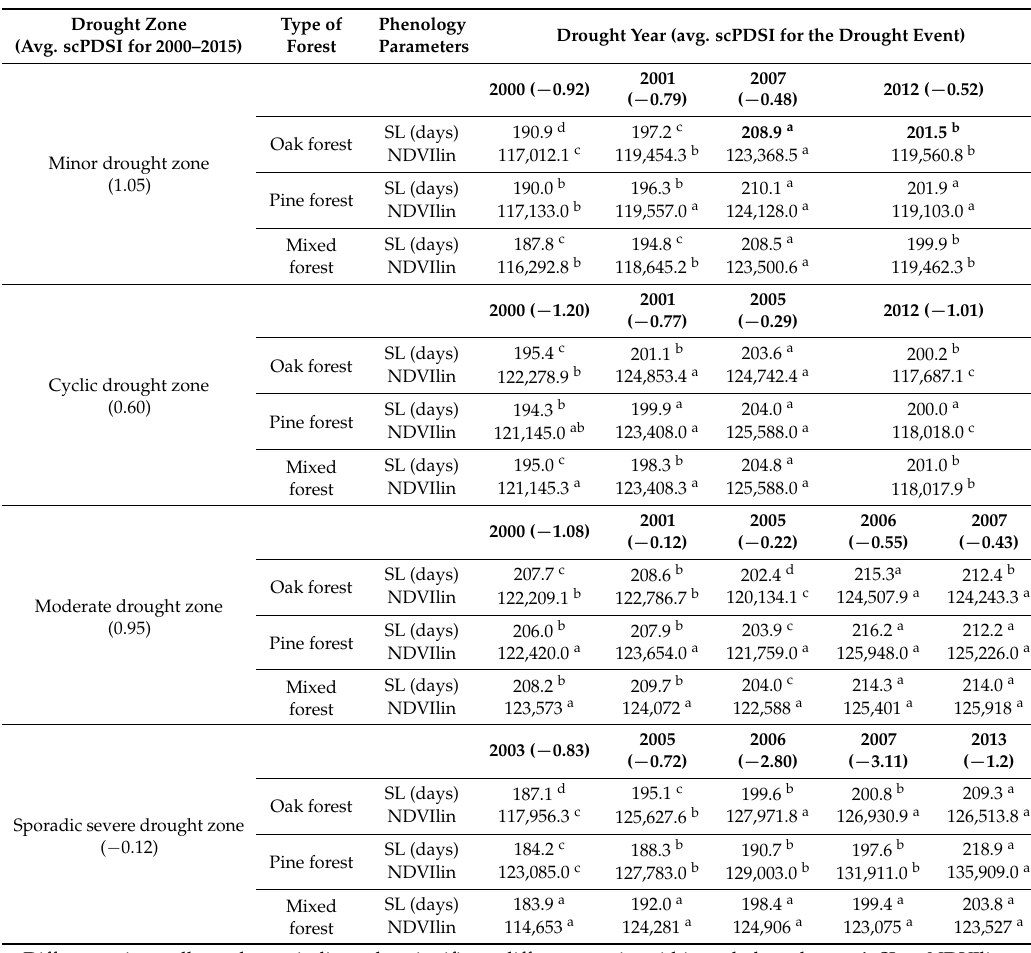
Table 3. Average SL and NDVIlin of each drought event in each drought